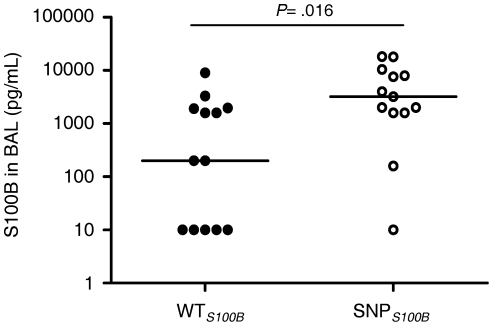
S100B concentrations in BAL samples from patients with proven/probable IA (n = 26) that received graft from wild-type (WTS100B, n = 13) or polymorphic (SNPS100B, n = 13) donors.Median S100B levels: 203 pg/mL and 3218 pg/mL for patients with IA receiving graft from WTS100B or SNPS100B donors, respectively (P = 0.016, by Mann-Whitney U test).